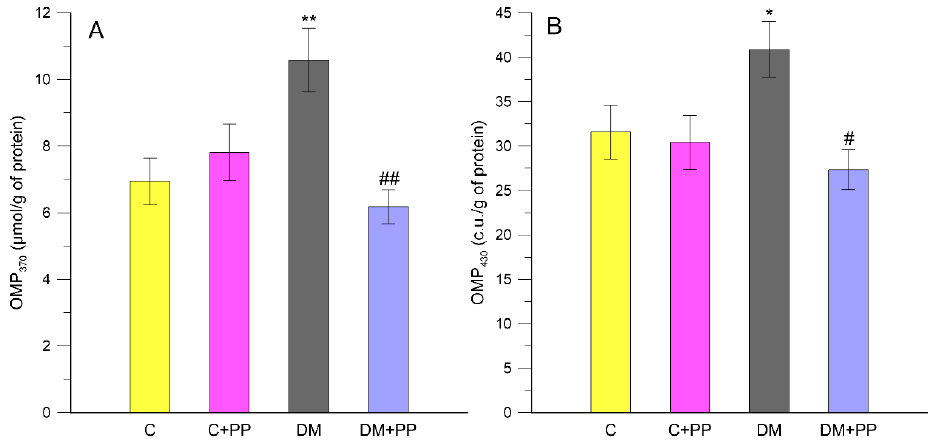
Figure 4. Oxidative modified proteins (OMP) of neutral ( A ) and basic ( B ) characteristics in rats ′ blood plasma. C—control group, C + PP—control rats receiving extract from Blue Congo (daily dose of 165 mg/kg b.w. for 14 days), DM—diabetic group, DM + PP—diabetic rats treated with Blue Congo extract (daily dose of 165 mg/kg b.w. for 14 days). The results are shown as means ± SD. Designations: * p <